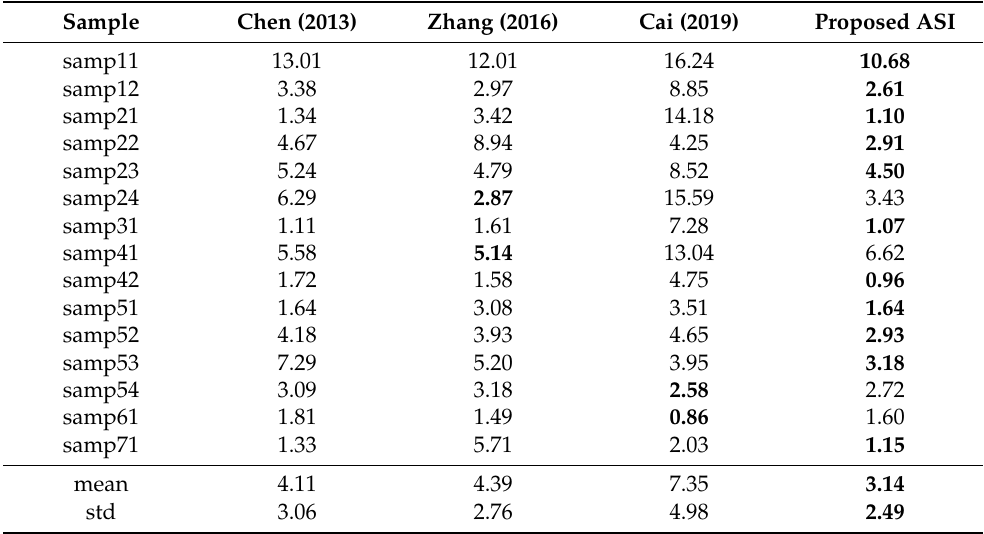
Table 7. Comparison between the T.E. values (%) of the proposed method and the inspired methods. (The best results across all the methods at each sample are highlighted in